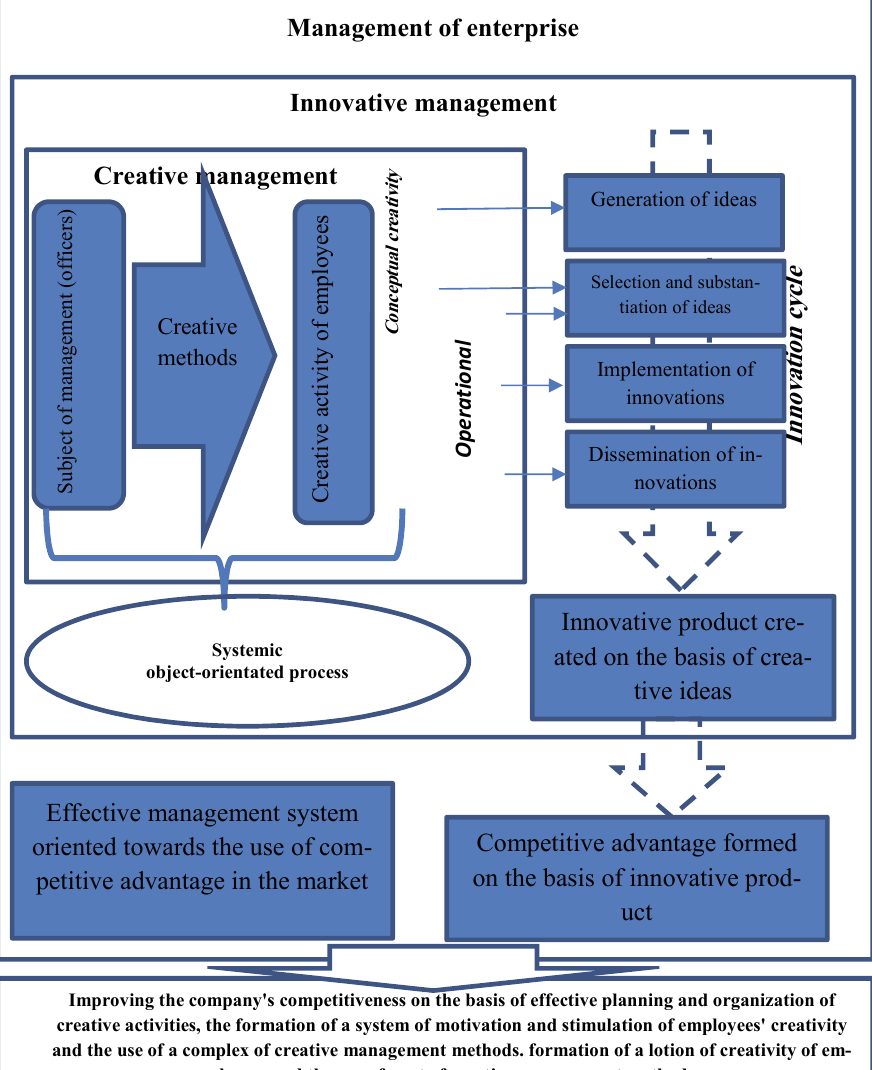
Fig. 2. Innovation activity management system using creative methods, focused on improving the competitiveness of enterprises. Source: author’s